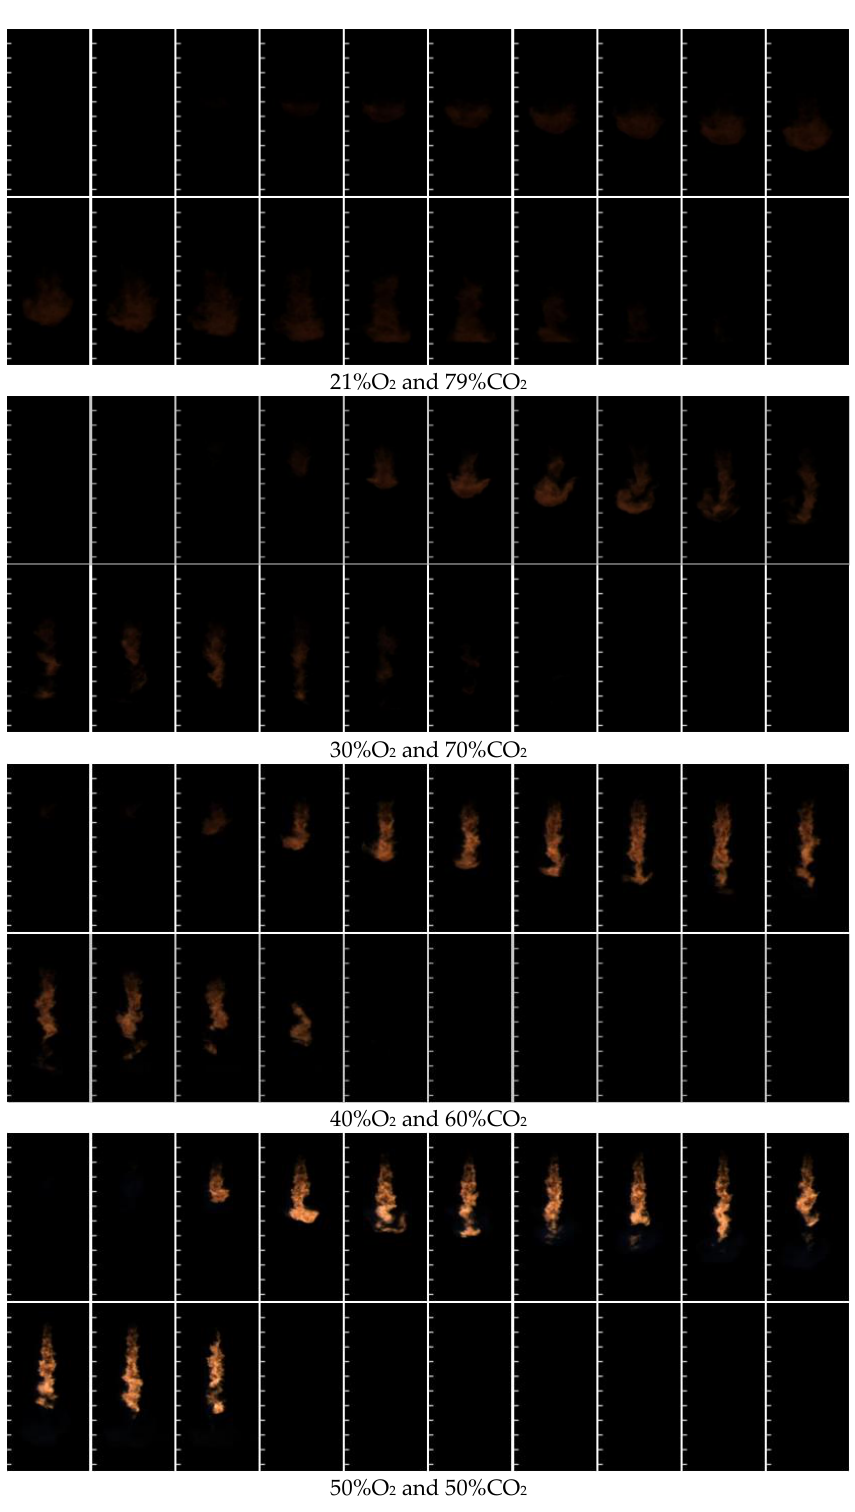
Figure 4. Comparison of combustion flames under different nitrogen-free conditions. The constant volume combustion vessel test was carried out by increasing the O 2 concentration to 30%, 40%, or 50% in a nitrogen-free environment, as shown in Figure